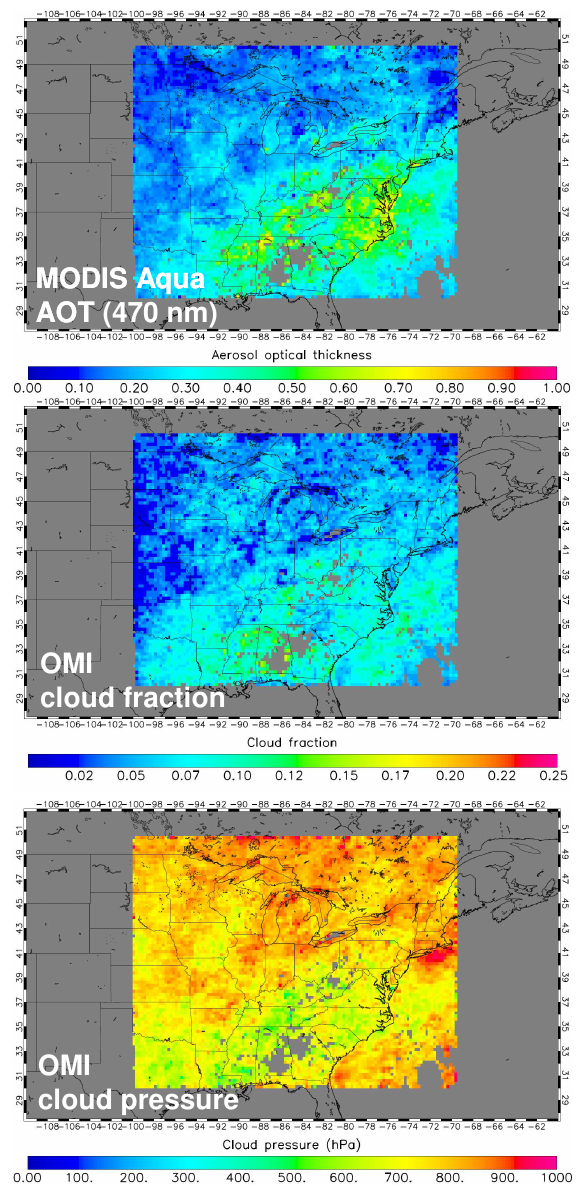
Fig. 11. Monthly average aerosol optical thickness observed from MODIS Aqua at 470 nm (upper panel), and corresponding OMI O 2 - O 2 effective cloud fraction (middle panel) and effective cloud pressure (lower panel) for July 2005. Cloud fractions have been selected only for those days and locations that had a successful, cloud-free, MODIS AOT retrieval 15 minutes prior to the OMI observations. Grey areas indicate less than 3 successful coincidences in July 2005.